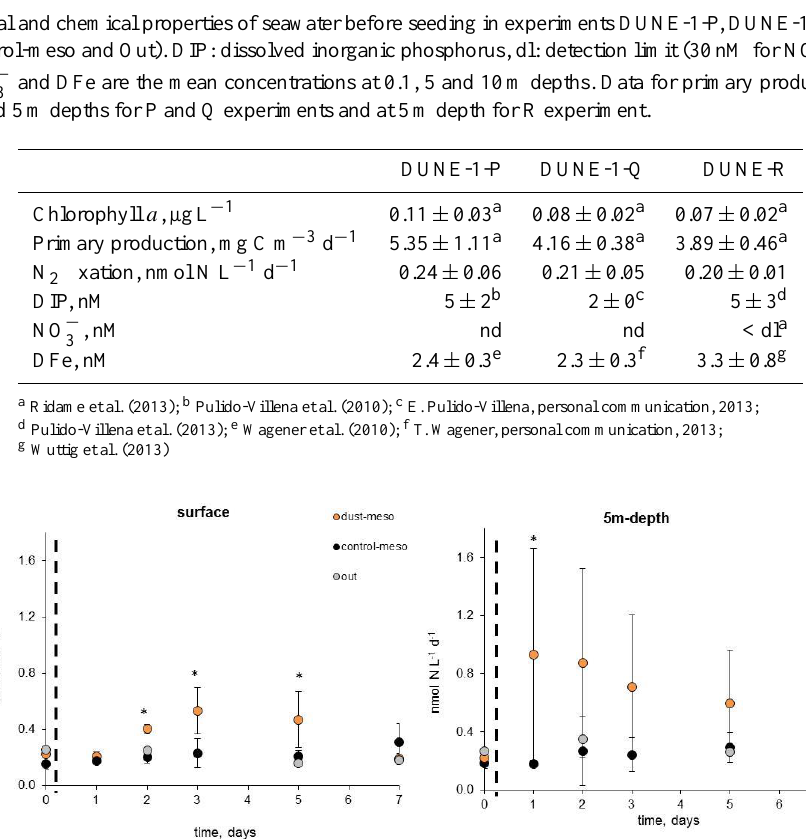
), nd: no data. Data for 3